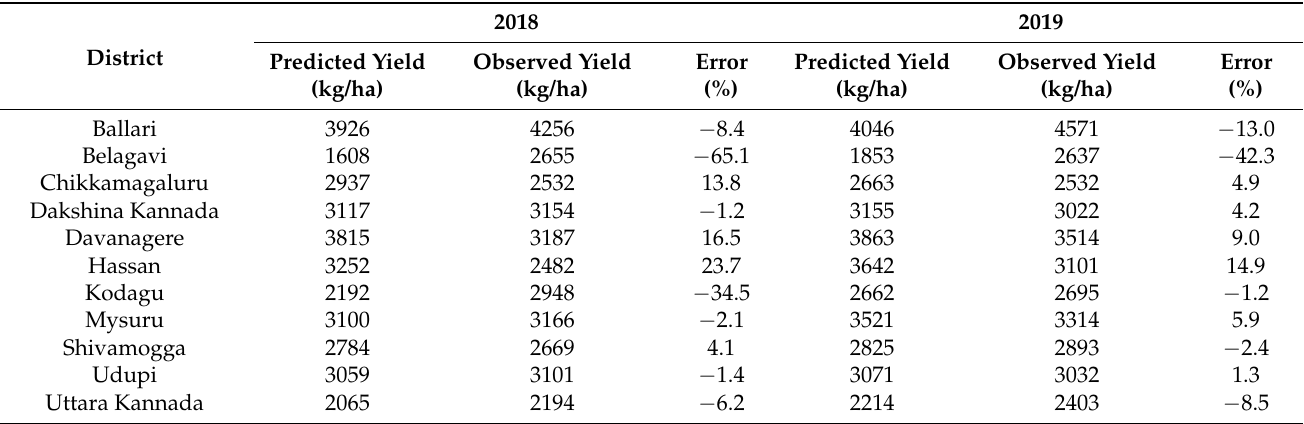
Table 5. District-wise error percentage of Kharif rice yield (Kg/ha) at preharvest (F3) stage, validated for 2018 and 2019 using a stepwise multiple linear regression.